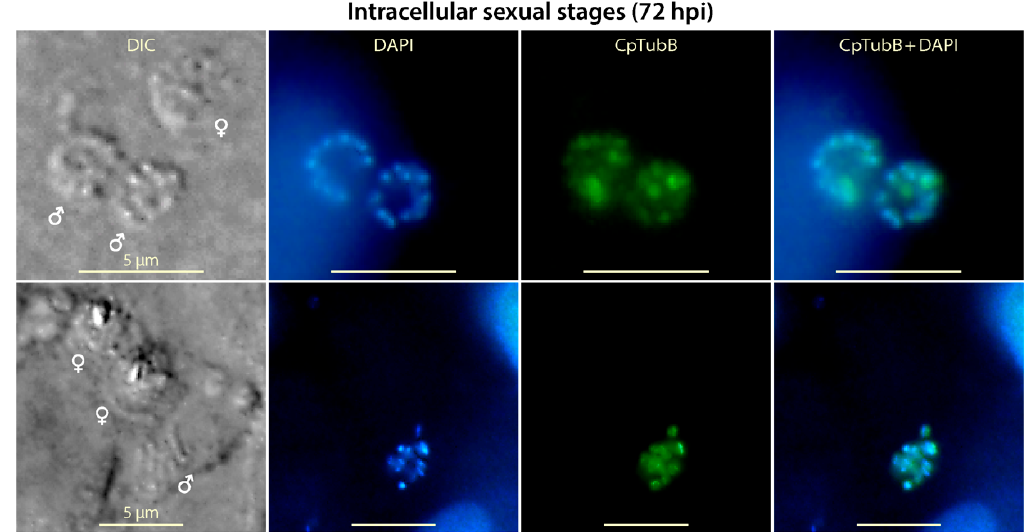
Figure 6. IFA detection of tubulin-based structures in intracellular Cryptosporidium parvum in sexual developmental stages at 72 h post-infection (hpi). Both nuclei (blue) and tubulin structures (green) were detectable in the microgametes (marked by male signs) by 4 ′ ,6-diamidino-2-phenylindole (DAPI) and anti-CpTubB antibody, but not in the macrogametes (marked by female signs). Note it is characteristic to C. parvum that the nuclei of macrogametes were unable to be stained by DAPI. DIC, differential interference contrast microscopy.